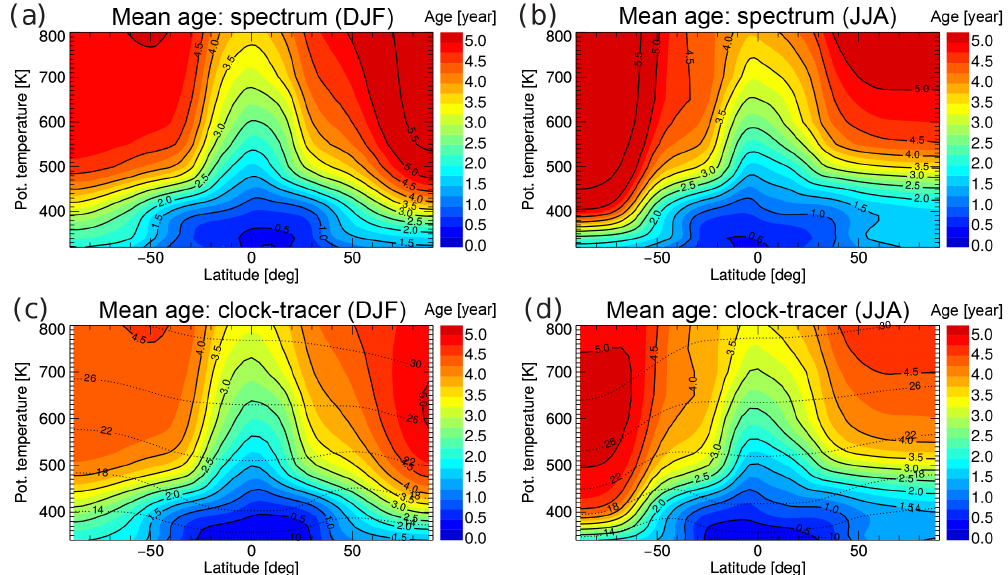
Figure 4. Mean age from the 1989–2013 CLaMS age spectrum climatology for (a) December–February and (b) June–August. Corresponding mean ages calculated from the model’s “clock-tracer” are shown in (c) and (d) for comparison. Black dotted lines in (c, d) show altitude levels in km for